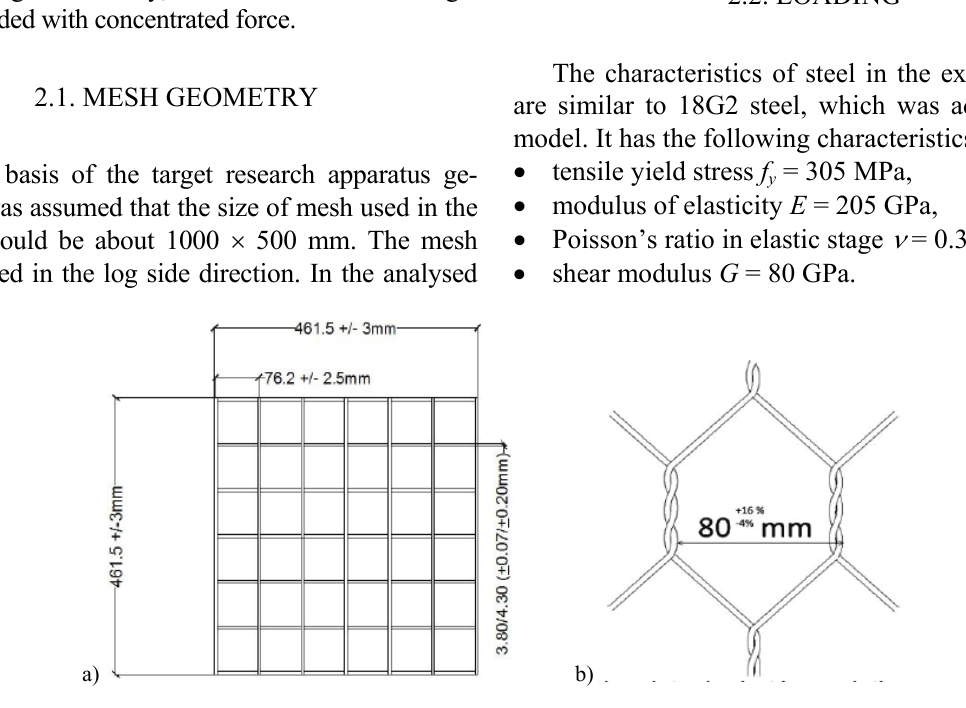
Fig. 3. Geometry of: a) welded mesh [9], b) woven mesh